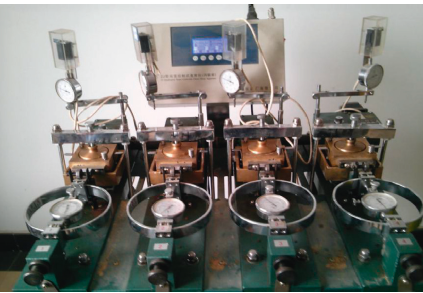
Figure 5: Direct shear test